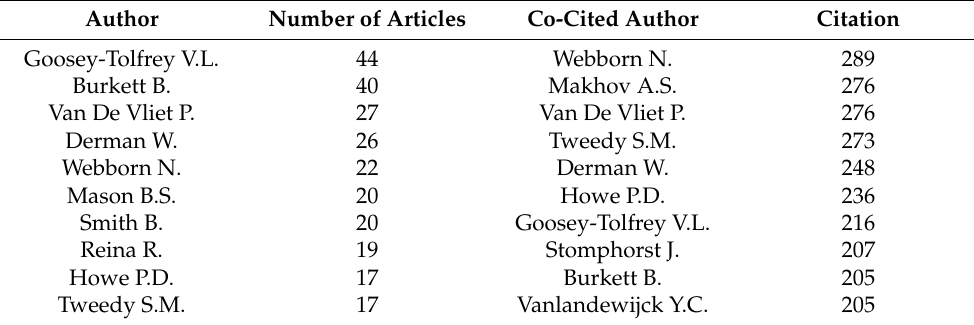
Table 4. The top 10 productive authors and co-cited authors in adapted sport